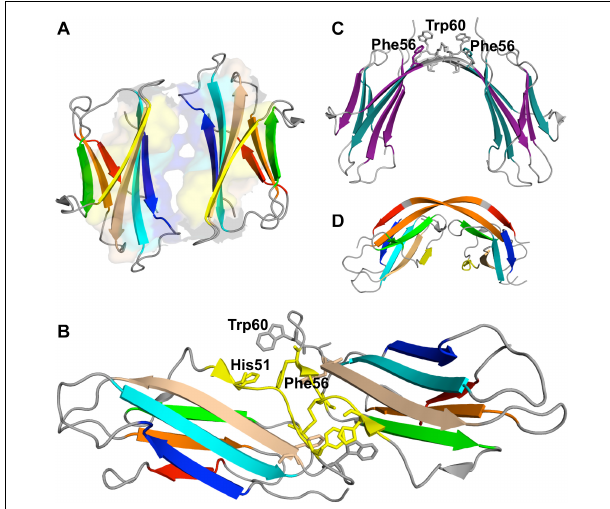
FIGURE 5 | Dimers of β 2m. P32A dimer featuring an anti-parallel eight-stranded beta-sheet ABED-DEBA (PDB ID: 2F8O), which is mediated by antiparallel interactions of two complete D strands (A) , DIMC33 formed by two S33C monomers linked by a disulfide bond at position 33 (PDB ID: 4R9H), which exhibits the DD strand interface (B) , domain-swapped dimer of the wt formed under reducing conditions, where strands E-F-G are exchanged between monomers (PDB ID: 3LOW); the residues forming the hinge loop, which contains amyloidogenic peptide segments, is highlighted (C) . Domain-swapped dimer of the (cid:49) N6 variant, which exchanges strand G (PDB ID: 2 × 89) (D)